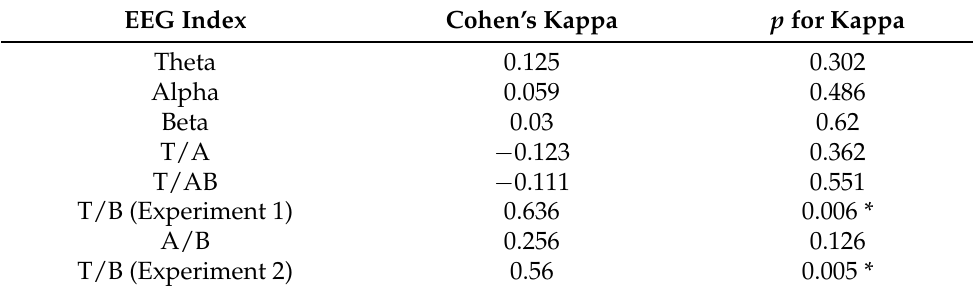
Table 6. Kappa between presence score and EEG